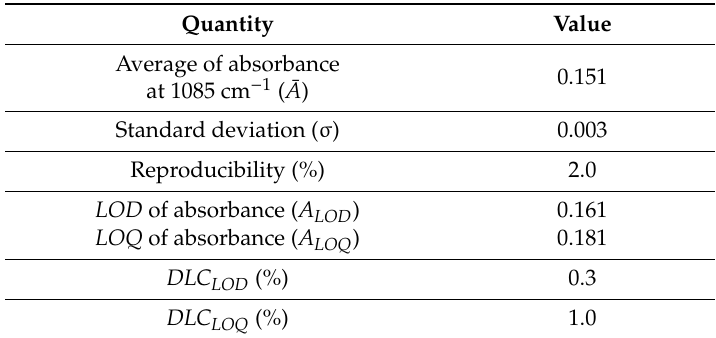
Figure 6. Baseline corrected and normalized spectra of the 10 blank SFN samples used for the calculation of limit of detection ( LOD ), limit of quantification ( LOQ ) and the reproducibility of the method. Table 2. Average ( ¯A )and standard deviation ( σ ) of absorbance at 1085 cm − 1 used for the calculation of limits of detection ( A LOD and DLC LOD ), limits of quantification ( A LOQ and DLC LOQ ) and reproducibility of the method according to Equations